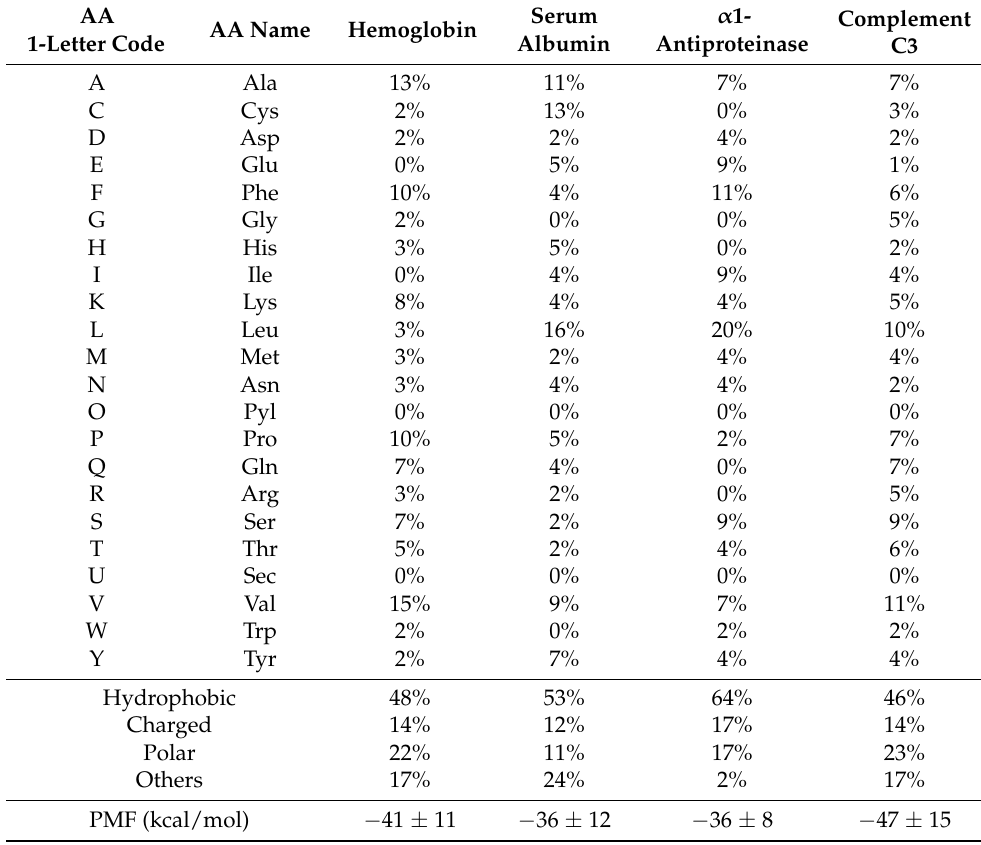
Table 1. The contact probability for each amino acid in each protein and for the physico-chemical amino acid types. At the bottom of the table is the average value of the Potential of Mean Force (PMF) for each protein upon AuNP